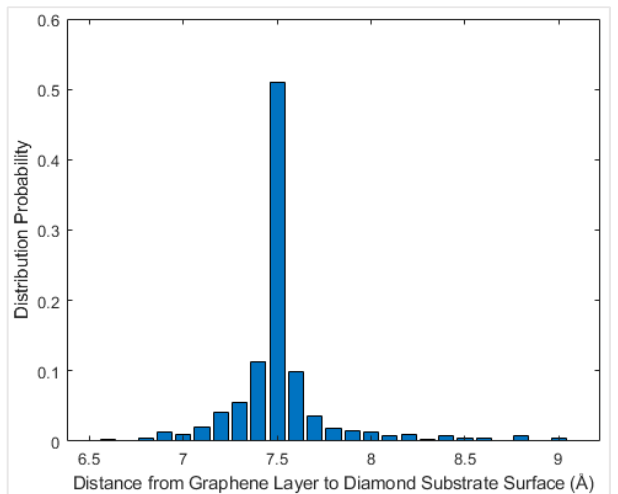
Figure 5. Probability distribution of the distance between graphene nanoflake and the diamond surface at 0 K.